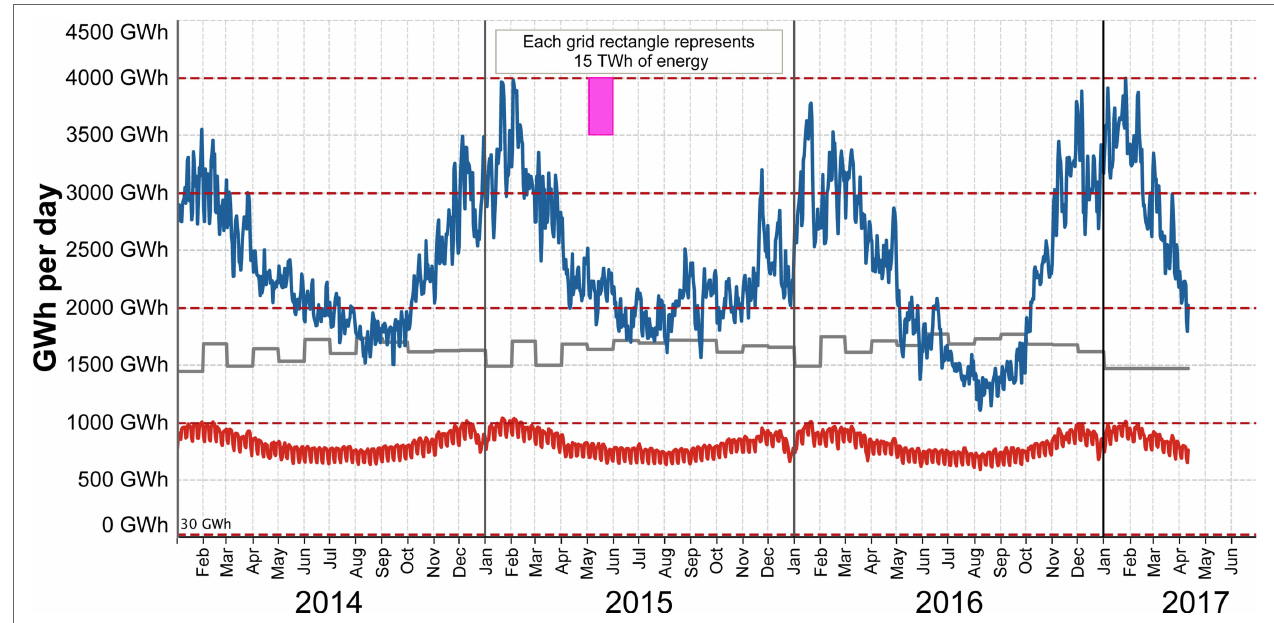
FiGUre 1 | Daily Shared Axis Energy Diagram for Great Britain 2014–2016. Data sources, National Grid, Elexon, and BEIS. Data sources are described in Wilson et al.